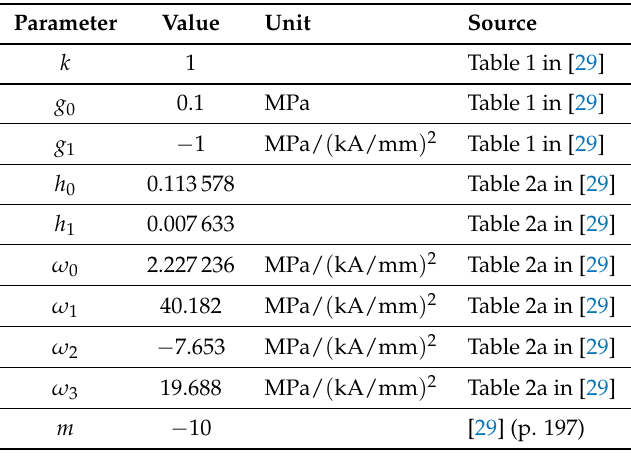
Table 1. Material parameters used for validation taken from [29].